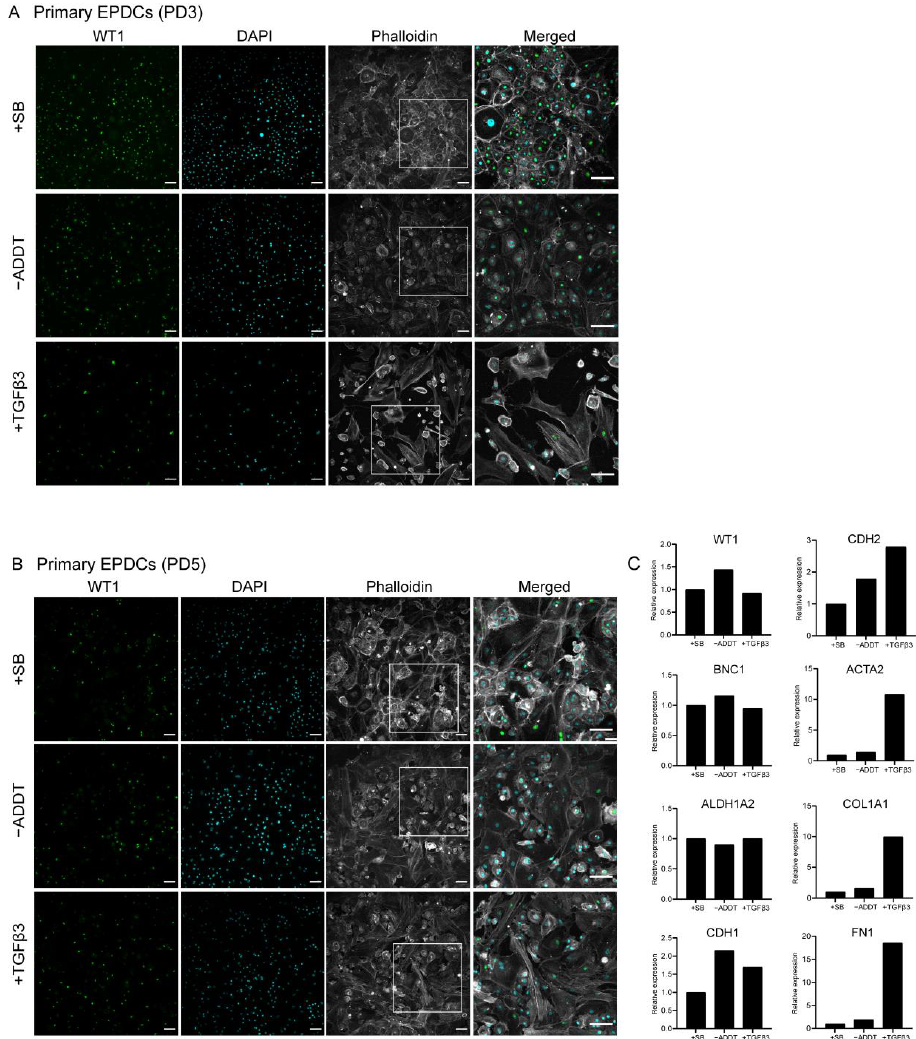
Figure 2. Primary human EPDCs undergo EMT and show a mesenchymal phenotype upon TGF β 3 stimulation. ( A ) Immunostaining showing that SB-treated primary human EPDCs of PD3 display a typical cuboidal epithelial morphology (indicated by phalloidin staining) and nuclear WT1 ex- pression. TGF β 3-treated primary EPDCs undergo EMT, acquire a spindle-like appearance, which is accompanied by a large decrease in the percentage of WT1-positive cells. Culture without SB or TGF β 3 causes a small fraction of PD3 EPDCs to lose their cuboidal morphology and nuclear WT1 expression. ( B ) Immunofluorescent staining of primary human EPDCs of PD5 subjected to the same treatments as in ( A ) Irrespective of the specific culture conditions, primary human EPDCs of PD5 show a low percentage of WT1-positive cells and display signs of EMT. ( C ) Assessment by RT-qPCR of epithelial and mesenchymal marker gene expression in primary human EPDCs of PD5 cultured under different conditions. Technical replicates: 3, biological replicates: 1. Scale bar = 100 µ m. − ADDT = no